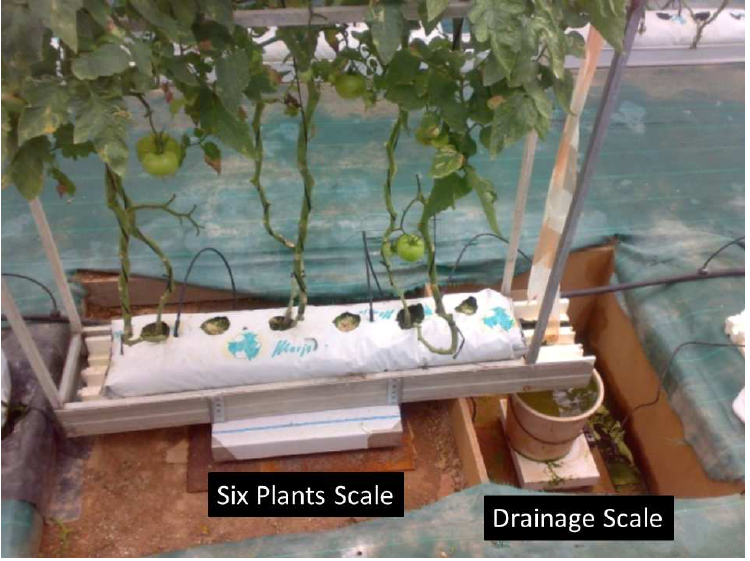
Figure 6. Lysimeter installed in the greenhouse for the transpiration